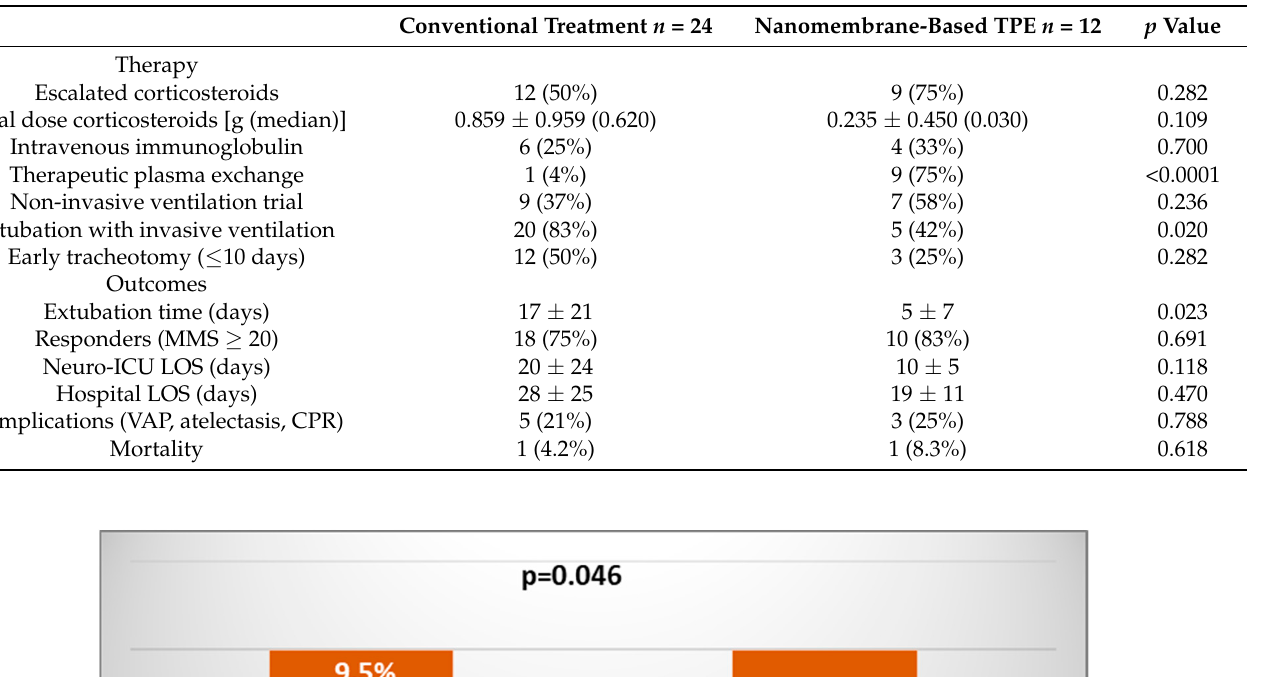
Table 2. Treatment and outcomes before and after the introduction of the novel nanomembrane-based TPE technology (MMS—Myasthenia Muscle Score, ICU –intensive care unit, LOS—length of stay, VAP—ventilator-associated pneumonia, CPR—cardio-pulmonary resuscitation).